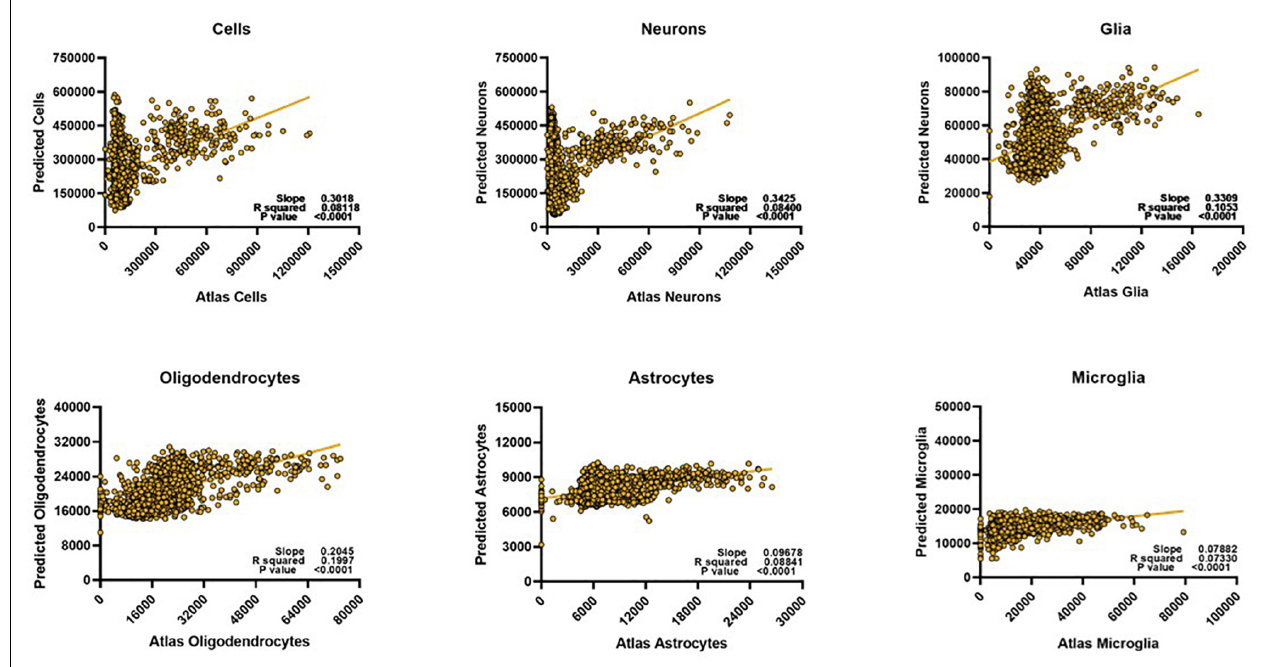
FIGURE 3 | Despite optimization, whole brain voxel-wise relationships cannot be exploited to develop meaningful prediction models for most cell types. We could only successfully estimate oligodendrocyte counts for the whole brain. Predicted scale = 2 × atlas scale.